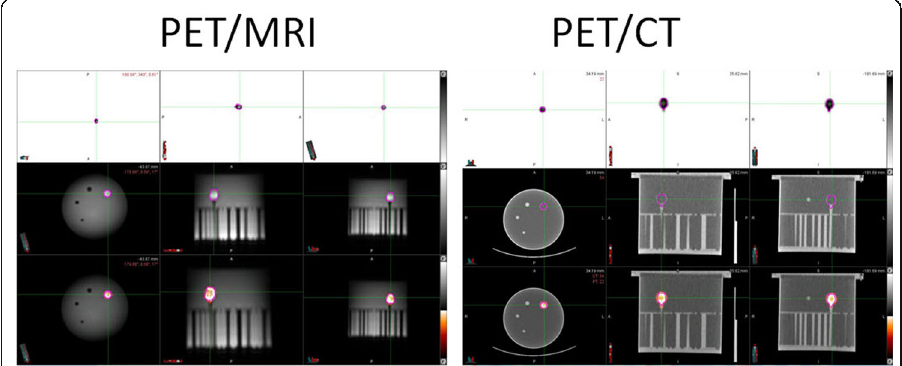
Fig. 1 PET/MRI and PET/CT images of the Jaszczak water-filled phantom with a 24.8-mm fillable sphere, filled with 1147.0 MBq of 90 Y-chloride. In the first row, there are PET images, in the second row MRI and